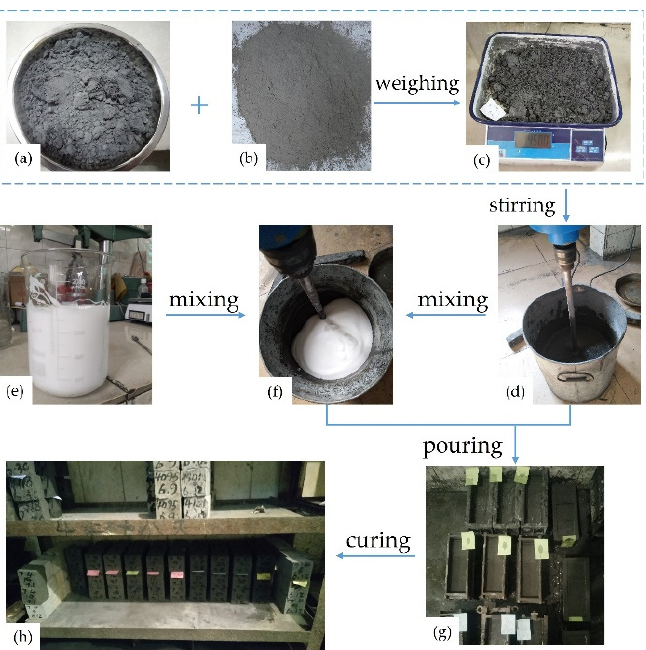
Figure 2. Manufacturing procedure of FCPB: ( a ) tailing; ( b ) cement; ( c ) materials weighing; ( d ) materials stirring; ( e ) foam preparation; ( f ) FCPB slurry preparation; ( g ) FCPB samples preparation; ( h ) curing room.